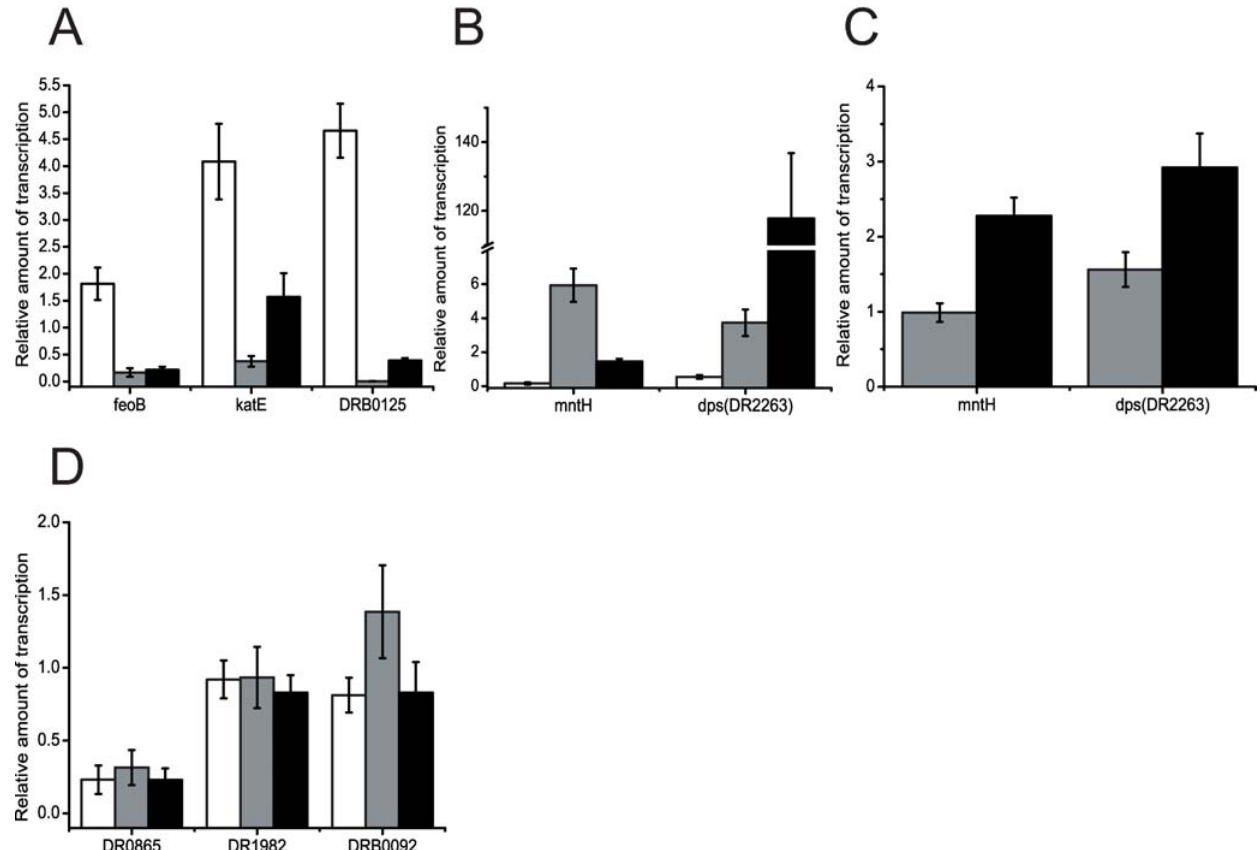
Figure 5. Q-RT PCR of the expression of potential OxyR-dependent genes in D.radiodurans R1 wild-type compared to wild type after H 2 O 2 treatment (white bar), MOxyR (grey bar), and MOxyR H 2 O 2 treatment (black bar). (A) genes positively regulated by DrOxyR; (B) genes negatively regulated by DrOxyR; (C) the expression patterns of DR1709 and DR2263 were measured in MOxyR_sdC; (D) genes not regulated by DrOxyR.